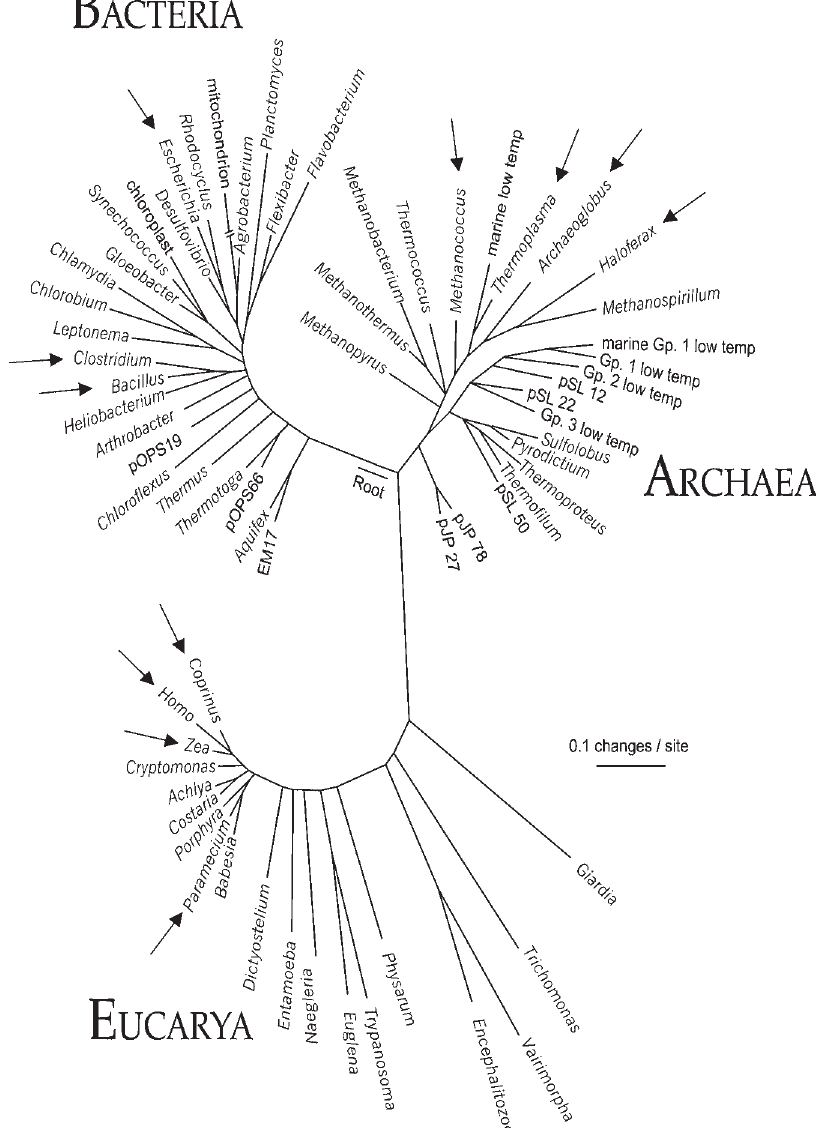
Figure 1. Universal phylogenetic tree based on small subunit rRNA se- quences (modified from Pace 1997, with permission). Organisms in each of the three domains in which MS chan- nel activities have been documented by structure or function are marked with